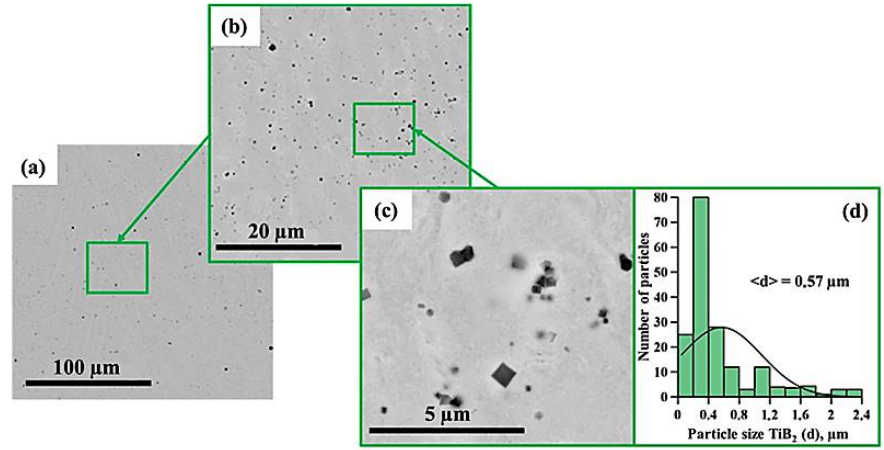
Figure 5. SEM image of the structure of a composite fabricated by direct laser deposition from the Inconel 625 + 5 wt% NiTi – TiB 2 powder mixture ( a – c ), histogram of the distribution of ceramic inclusions by size ( d ).